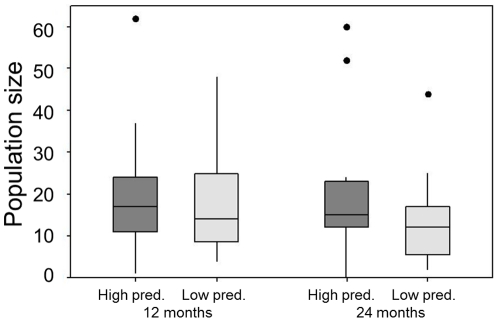
Population size of mesocosms.Numbers of individuals in populations founded by females originally from high predation and low predation localities after both 12 and 24 months. Medians, interquartile ranges and outliers (dots) are shown. N = 16 except ‘low predation, 24 months’, where N = 13.